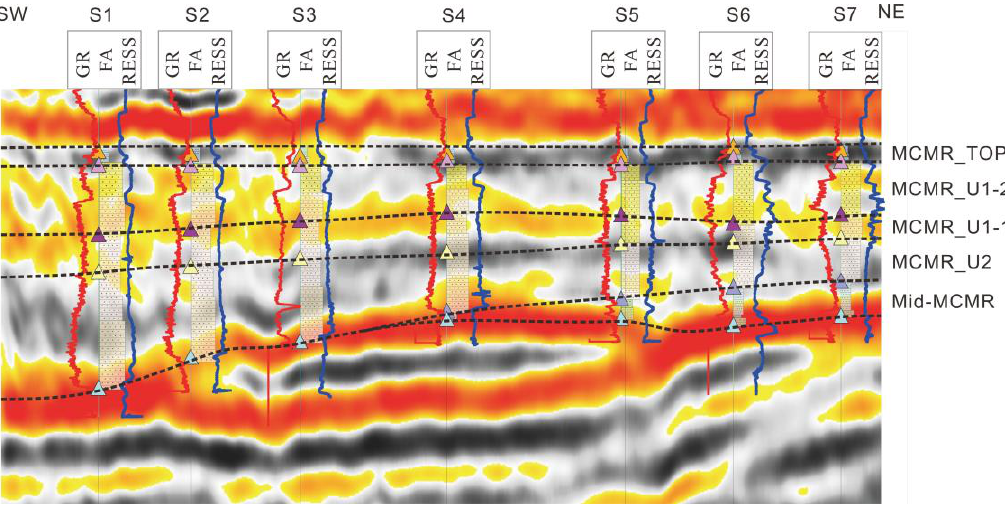
Figure 2. Architecture analysis of 2D seismic slice. The GR curve is on the left, the lithofacies association is in the middle, and the RESS curve is on the right.